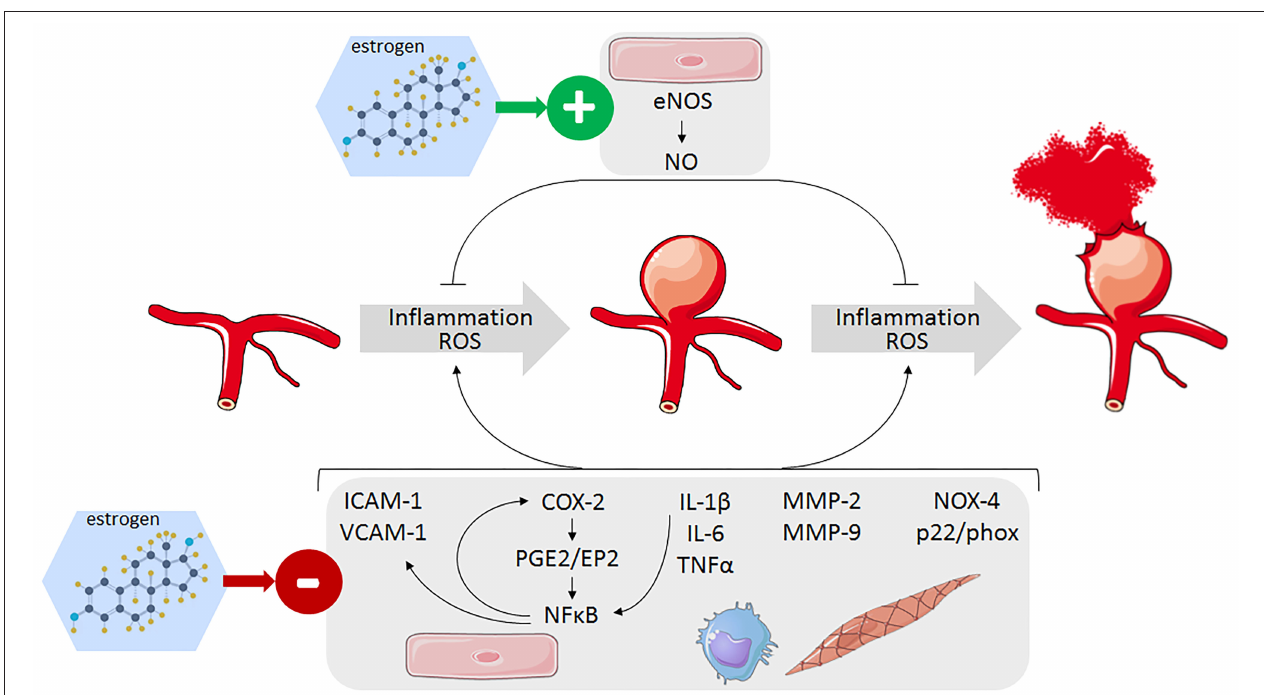
FIGURE 3 | Identified pathways involved in the protective effect of estrogens against IA formation and rupture leading to decrease inflammation and oxidative stress in the arterial wall of cerebral arteries. Endothelial cells (pink), monocytes/macrophages (blue), and smooth muscle cells (light brow).